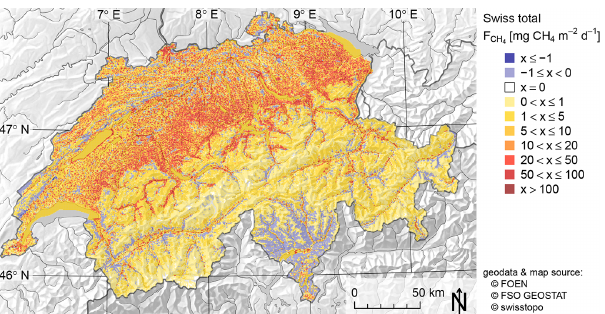
Fig. 1. Our spatially explicit Swiss CH 4 emission inventory includ- ing both anthropogenic and natural CH 4